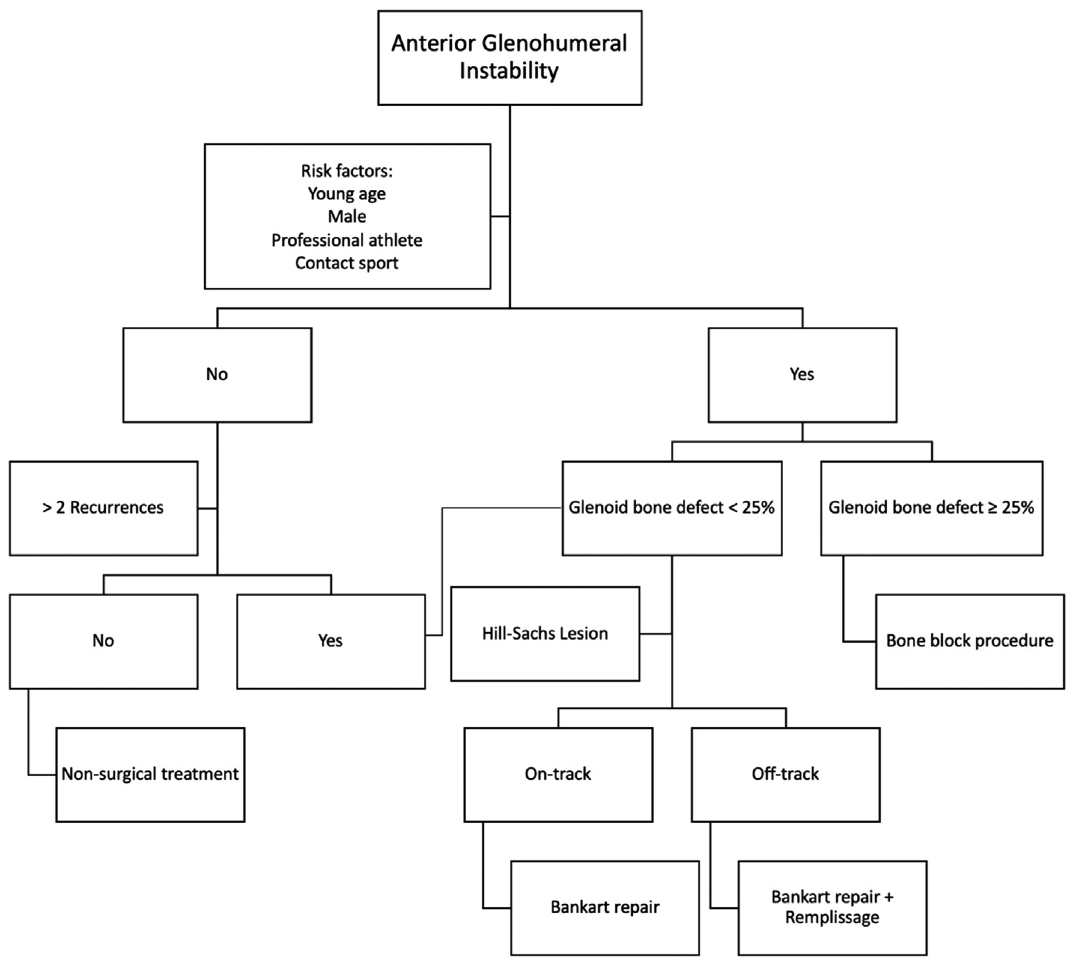
Figure 1. Algorithm for the management of patients with anterior glenohumeral